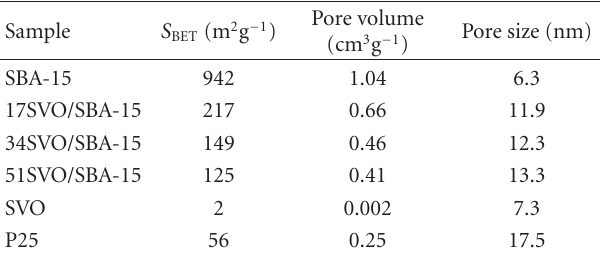
Figure 1: XRD patterns of SVO and SVO/SBA15 composites. Table 1: Specific surface area and pore properties of SBA-15, SVO/ SBA-15, SVO, and P25 materials.